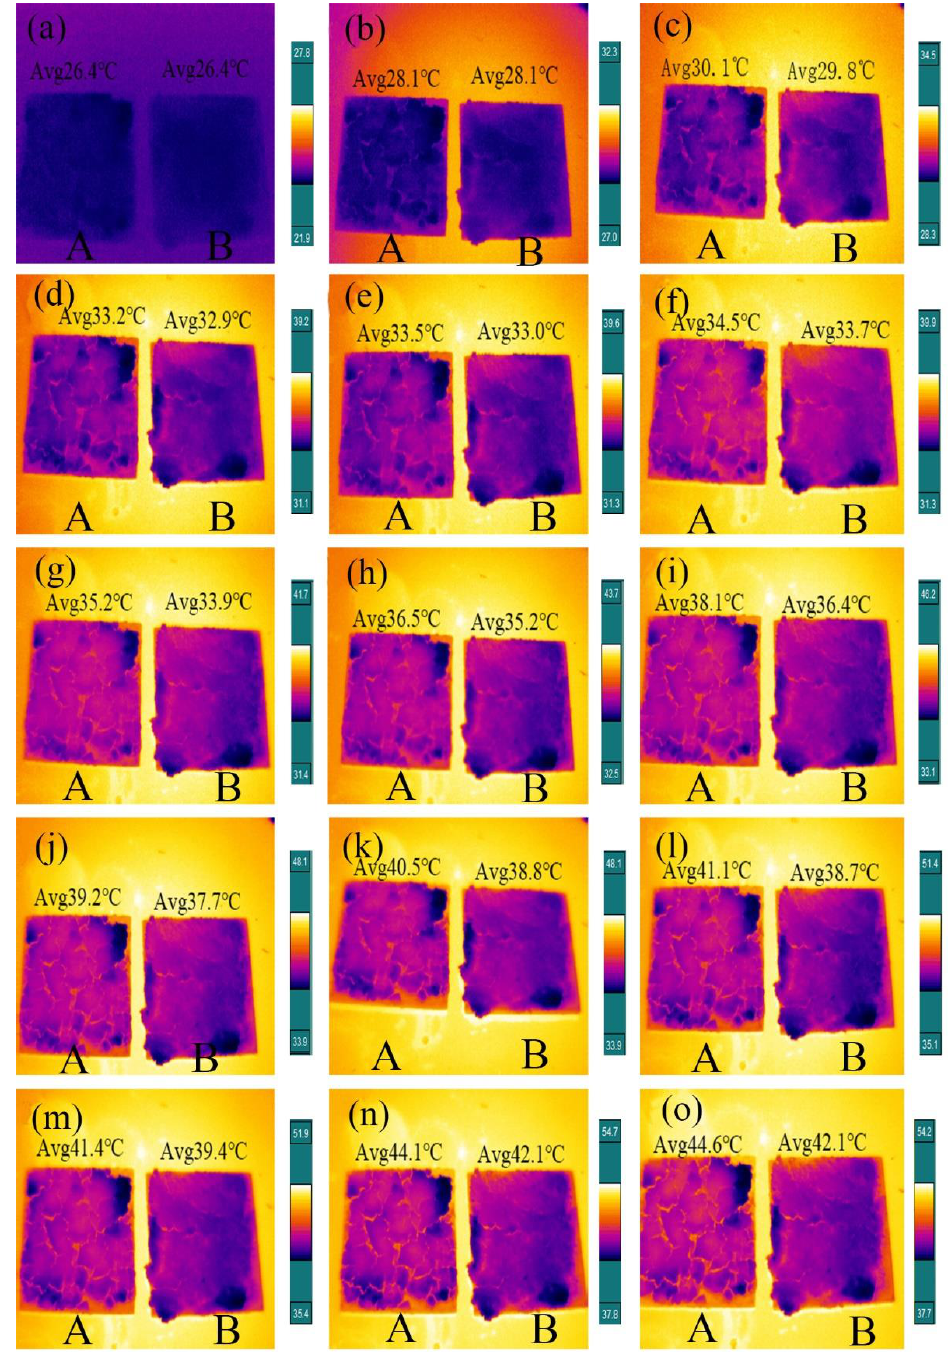
Figure 13. Thermal images ( a – o ) of sample A (normal colored latex paint coating) and sample B (novel colored latex paint coating containing paraffin@SiO 2 colored microcapsules).